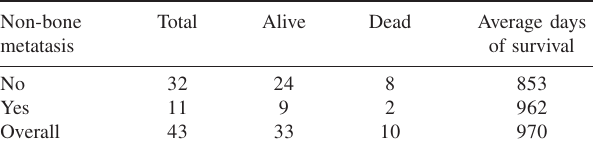
Table 5- Days of survival by presence of non-bone